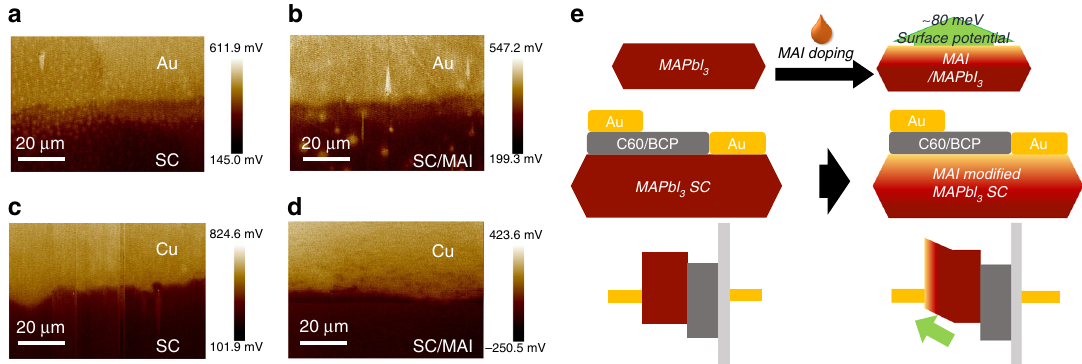
Fig. 2 Surface treatment on perovskite single crystal. a – d The KPFM images of the surface of single crystals before and after MAI treatment. e Schematic diagram of device structures and energy levels for SC-PSCs without and with MAI treatment.